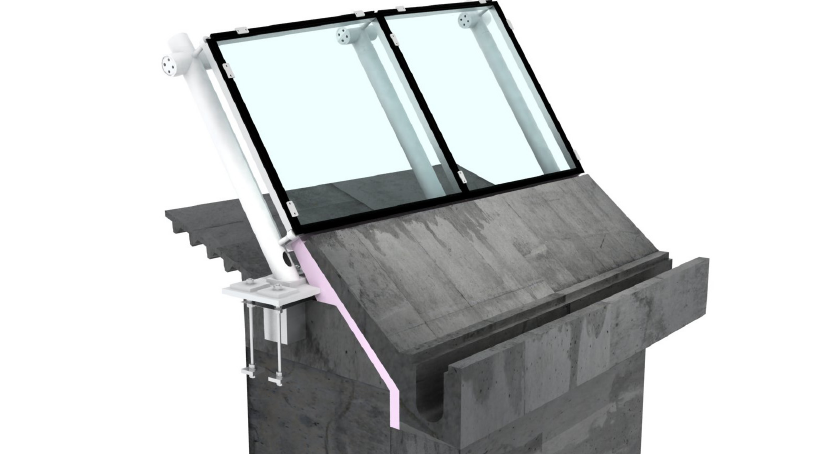
Figure 5: Rendering of the grid support details (© Glasbau Seele,